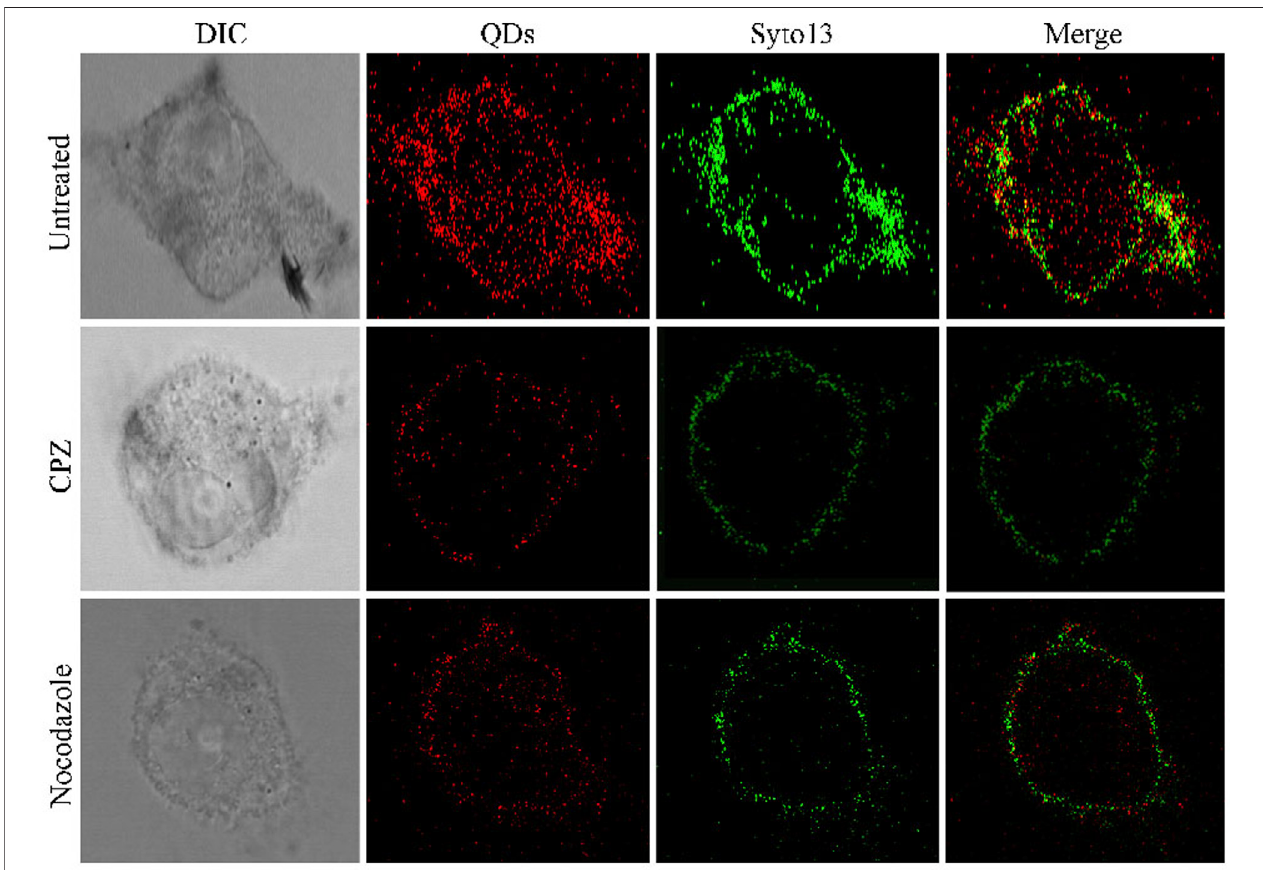
FIGURE 3 | Confocal microscopic images of ZIKV nucleic acid colocalized with the commercially available organelle trackers Syto13 in SNB19 cells treated with different drugs including chlorpromazine and nocodazole.